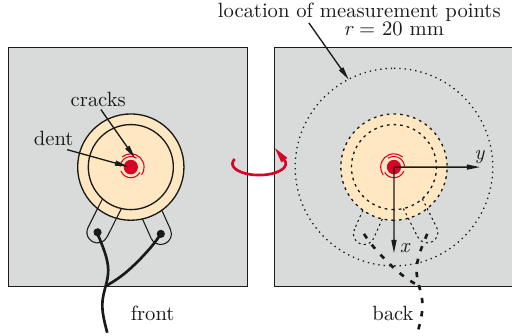
Figure 5. Location of the impact, leading to a dent, several crescent cracks and measurement locations to recognize changes of the velocity field in the structure.